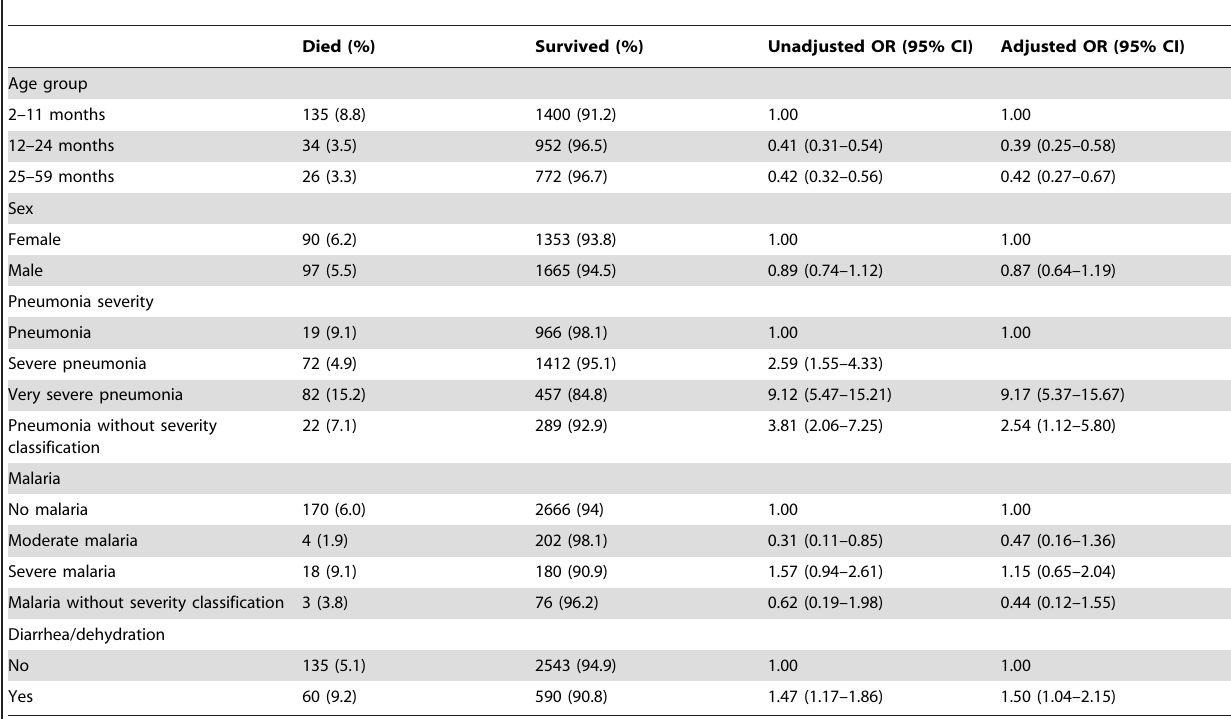
Table 3. Effect of age, sex, and comorbidity on pneumonia mortality adjusted for hospital.